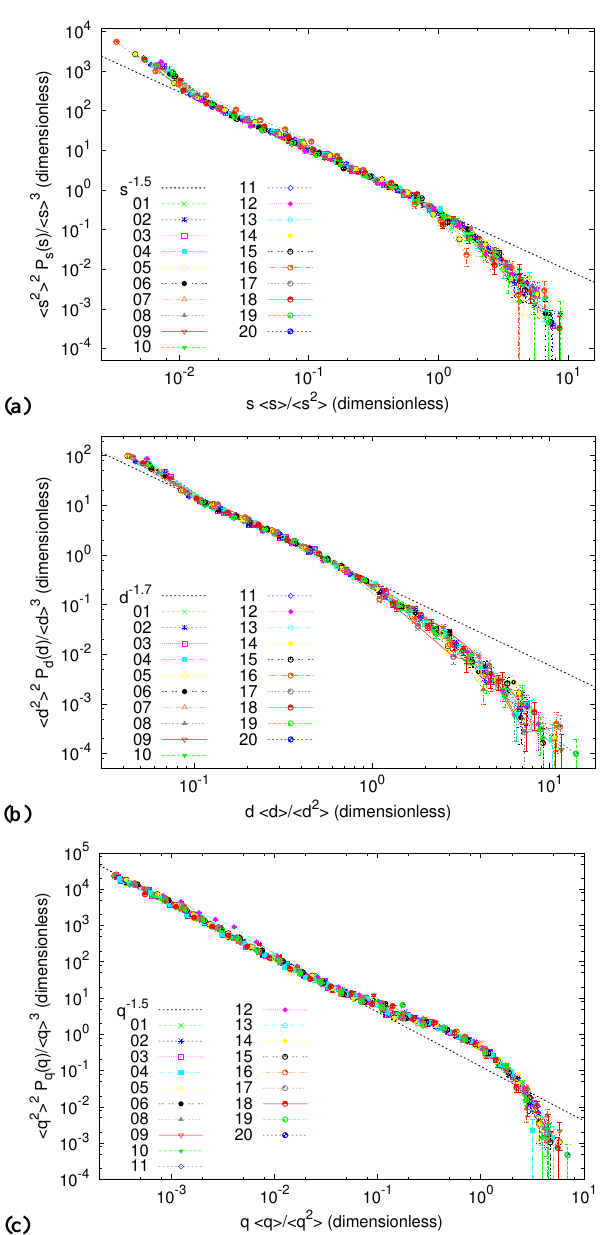
Fig. 3. Collapse of the probability densities for all the sites for the whole time covered by the record of: (a) event sizes, (b) event dura- tions, and (c) dry spells. Rescaling is performed using the first and second moment of each distribution, following Eq.